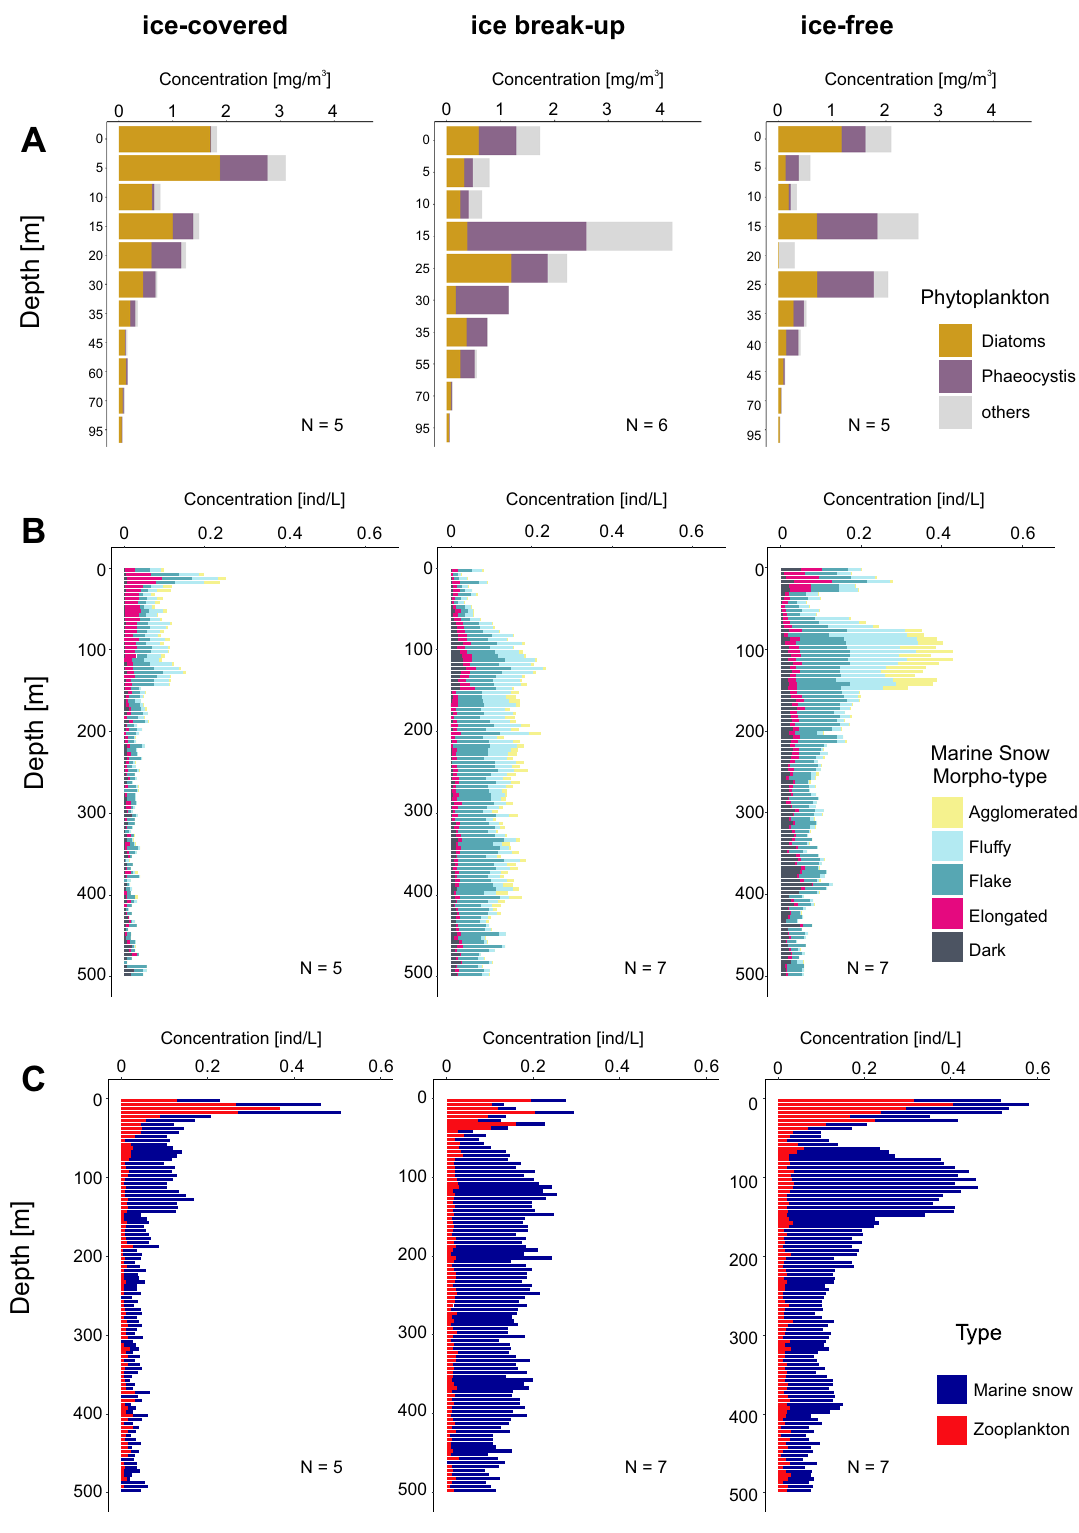
Fig. 5 Coupling between phytoplankton, marine snow morphotypes, and zooplankton among periods over de fi ned sea ice coverage phases in Fram Strait. A Pigment concentrations of dominant phytoplankton groups. B Cumulative concentrations of the different marine snow morphotypes. C Total concentrations of marine snow and